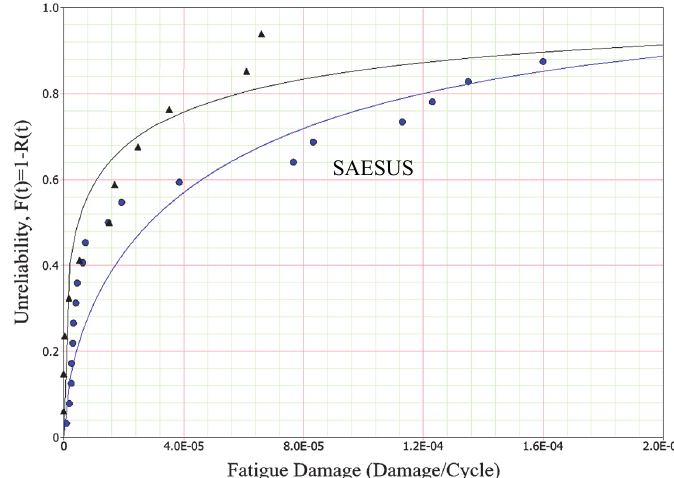
Figure 5: Probability density functions for SAESUS and S1 strain signal